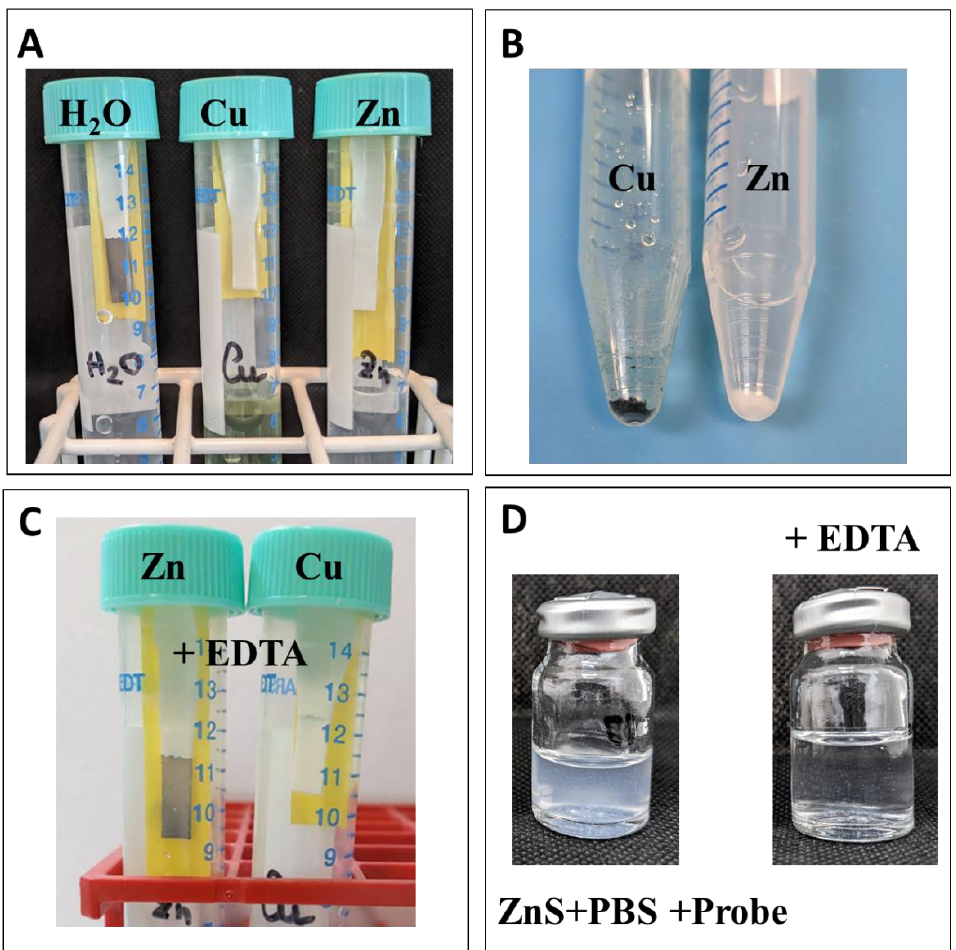
Figure 4. Efficiency of different trap solutions. ( A ) Detection of residual H 2 S from fermentation gas after bubbling through a solution containing H 2 O (control), CuCl 2 , or ZnC 4 H 6 O 4 . ( B ) Aspects of copper sulfide and zinc sulfide precipitates. ( C ) H 2 S release from the zinc sulfide (but not copper sulfide) complex, after EDTA addition. ( D ) dissolution of the zinc sulfide precipitate after EDTA addition. White/black strips respectively indicate the absence/presence of H 2 S.